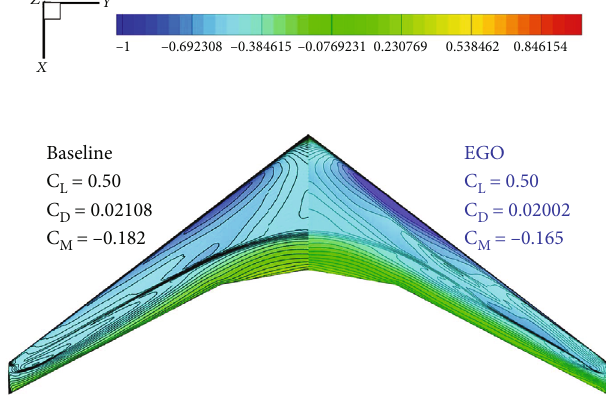
Figure 25: Pressure distributions of baseline and the